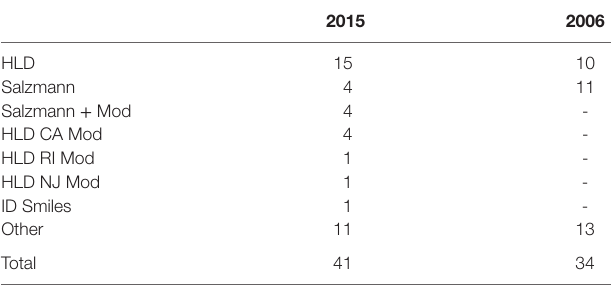
Table 3 | Comparison of the number of states requiring specific types of orthodontic